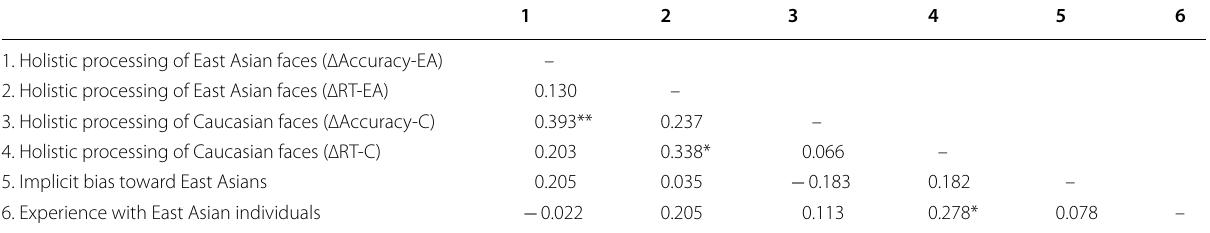
Table 3 Correlations among the dependent measures and predictors in Experiment 1